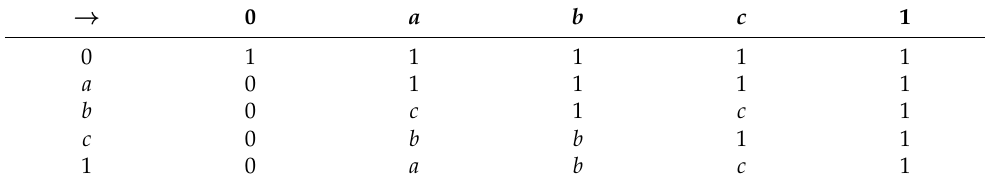
Table 8. The operation →